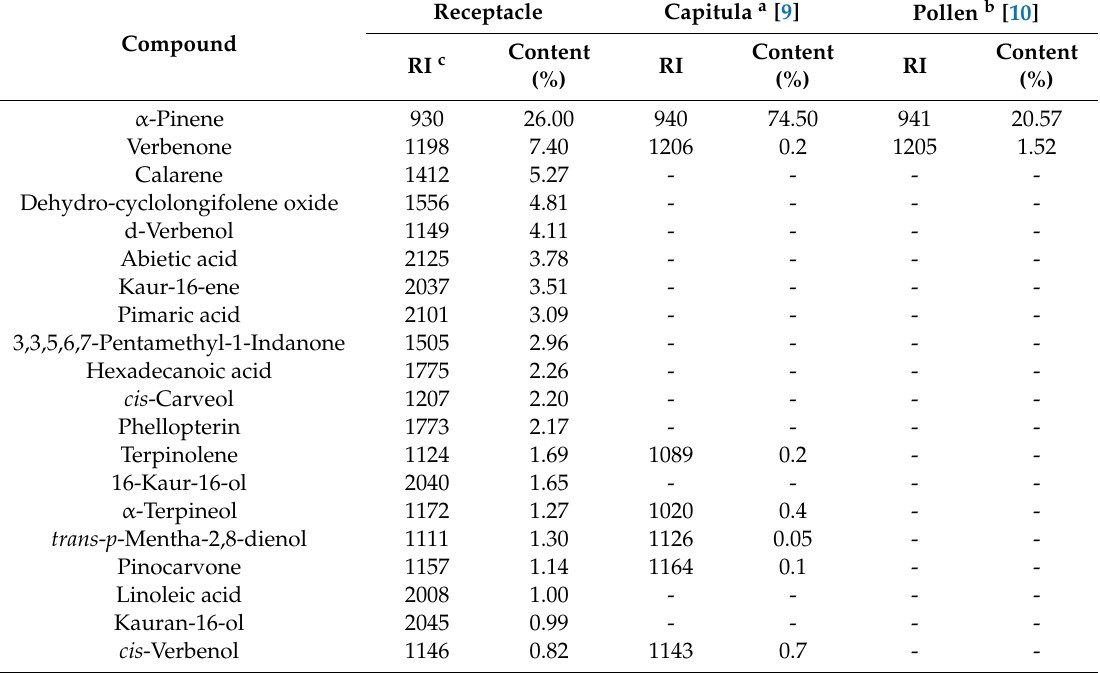
Table 2. Comparison of the main components of essential oil from di ff erent sunflower parts (receptacle, capitula and